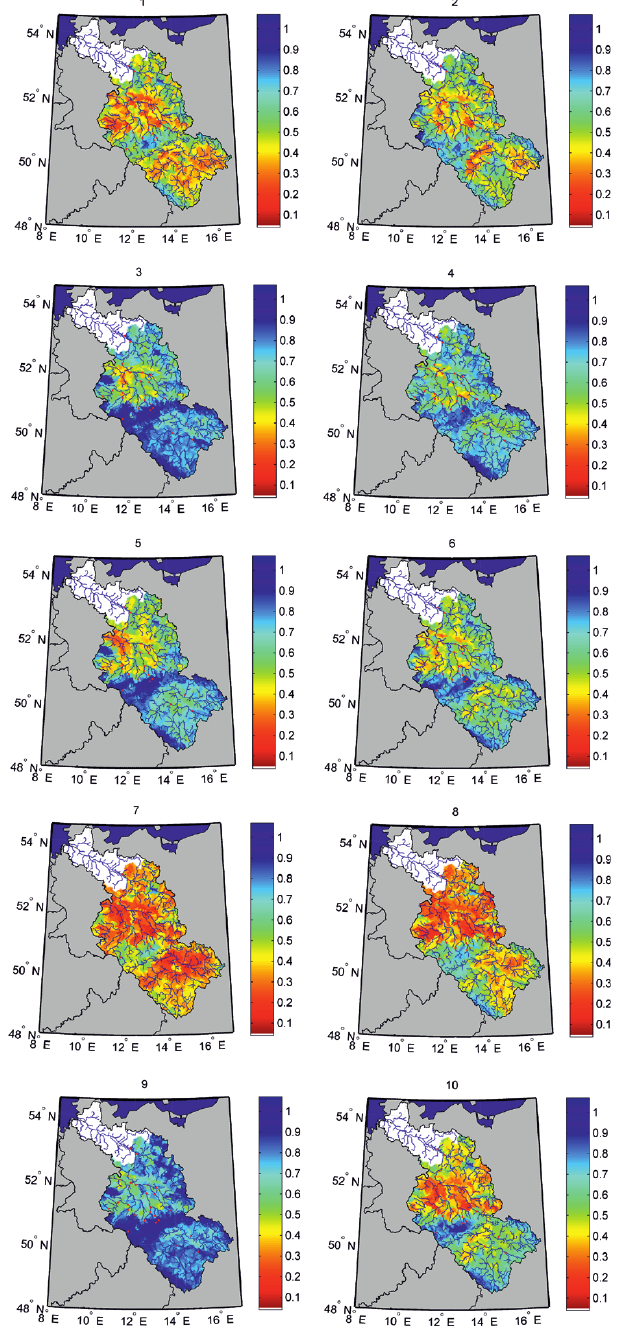
Fig. 6. Soil moisture index (SMI) patterns of cluster centroids.